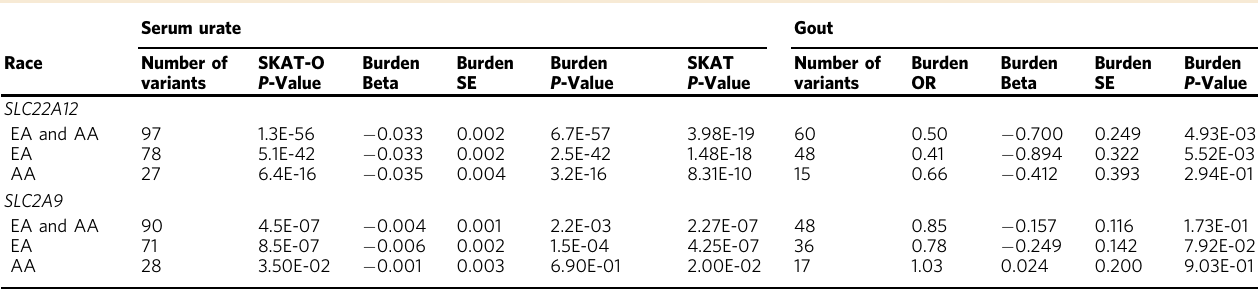
Table 2 Exome-wide signi fi cant genes for serum urate in primary SKAT-O meta-analysis of low-frequency (MAF < 5%) putative damaging variants Serum urate Gout